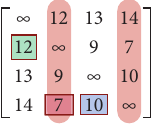
Figure 6: Discarding columns 2 and